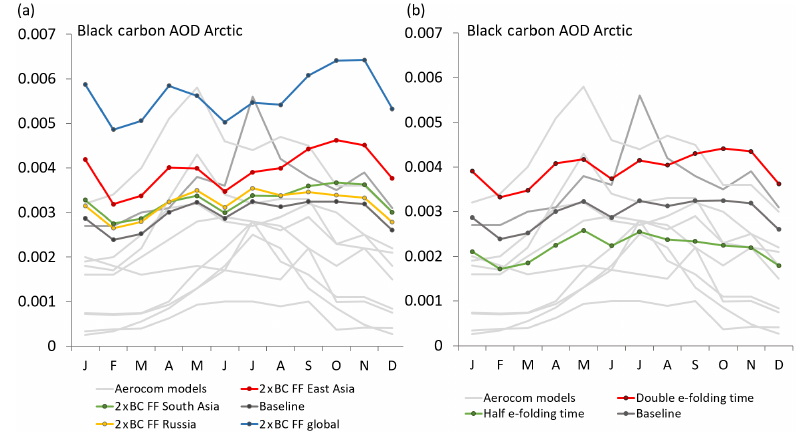
Figure 18. Arctic mean seasonal cycle of (total) BC AOD for simulations with GISS modelE (in colours) compared to the AeroCom models (in light grey). Panel (a) shows the experiment with doubling the emissions, while panel (b) shows the effect of changing the e -folding lifetime. The darker grey AeroCom model is the GISS modelE AeroCom run. Panel (a) shows emission perturbations for a doubling of BC emissions (fossil fuel and biofuel) in southern Asia (green), eastern Asia (red), Russia (yellow), and global (blue). Panel (b) shows double (red) and half (green) of the e -folding time from hydrophobic to hydrophilic BC.